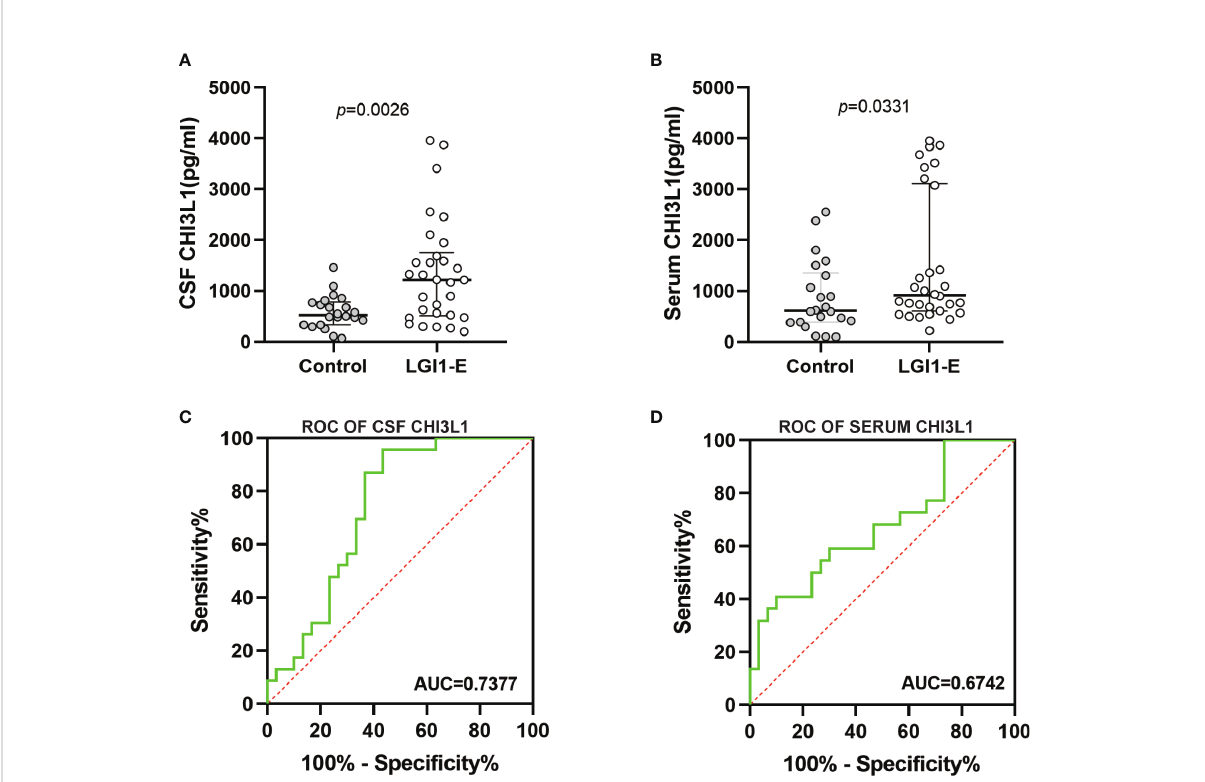
FIGURE 1 Levels of CHI3L1 in cerebrospinal fl uid (CSF) and serum. CSF (A) and serum (B) CHI3L1 levels in patients with anti LGI1 encephalitis and controls; (C) , (D) Receiver operating characteristic curves for CSF and serum CHI3L1 to discriminate anti-LGI1 encephalitis patients from control